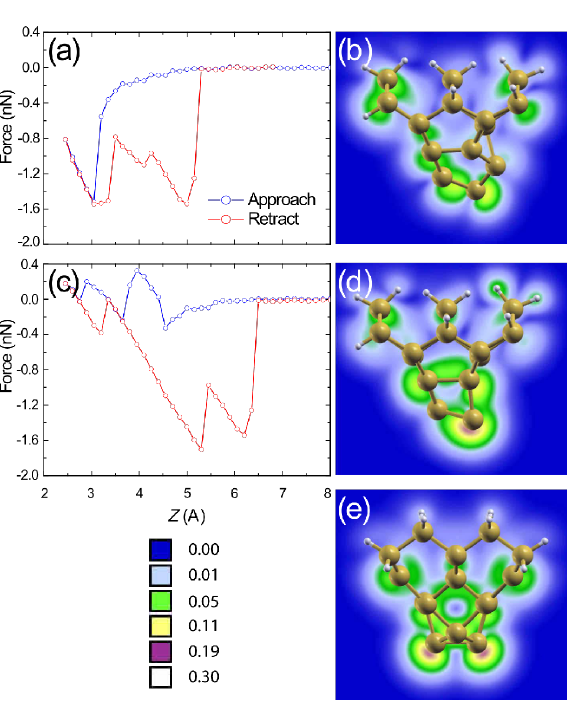
Figure 5: Continued development of tip D 2a via repeated tip indenta- tions. (a) Calculated F ( z ) curve and (b) final tip configuration following indentation of the tip structure shown in Figure 4(g) leading to tip D 2b . (c) Indentation of tip D 2b results in further modification noticeable as a series of sharp discontinuities in calculated F ( z ) prior to reaching a final, stable double tip shown from two perspectives in (d–e). Partial electron density plots shown with square root scale in units of elec- trons/Bohr 3